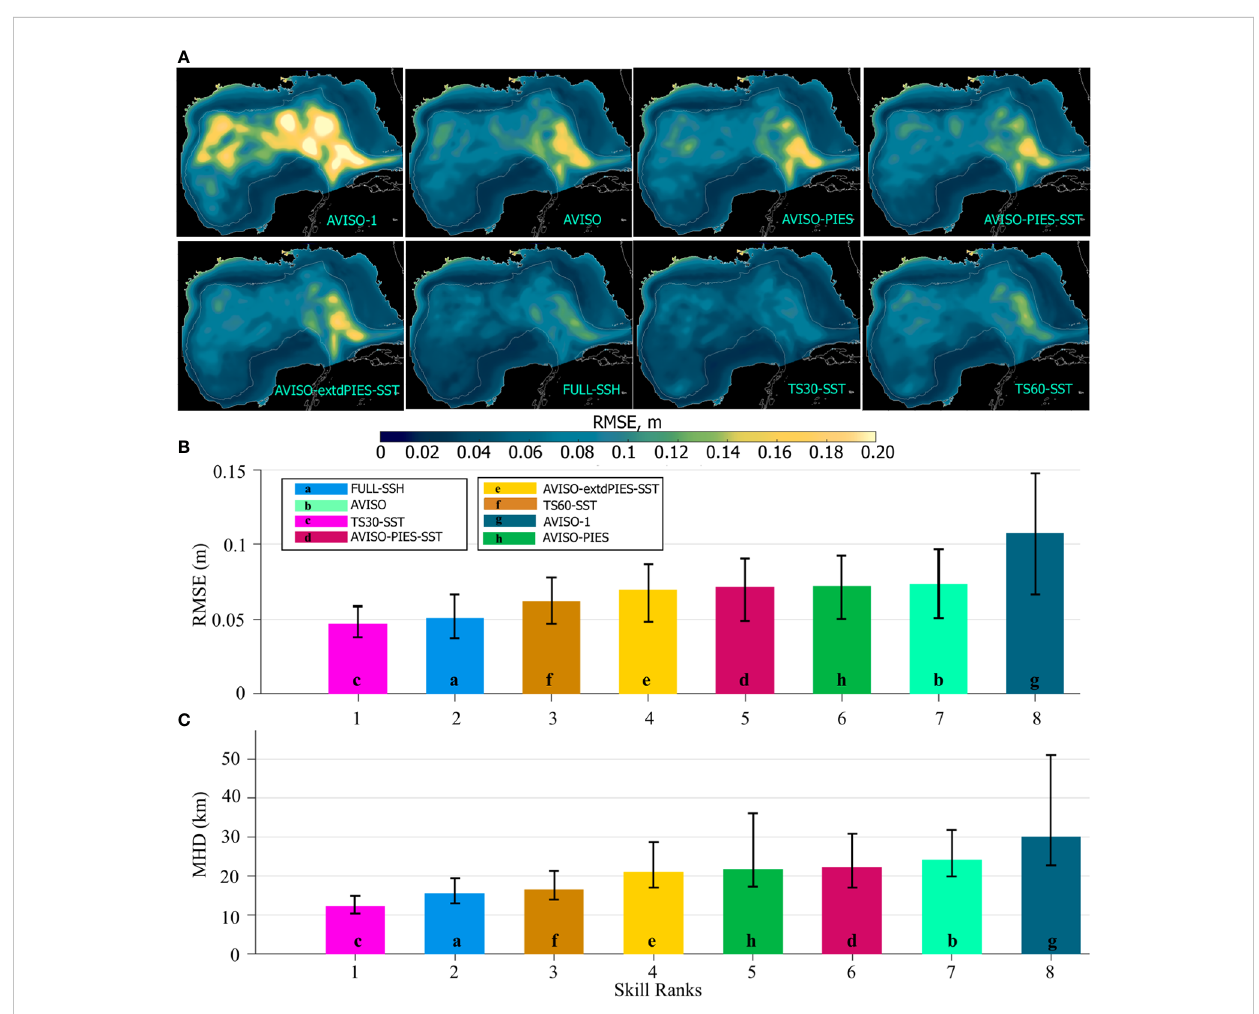
FIGURE 8 (A) Maps of mean RMSE (m) between daily SSH fi elds from the OSSE analysis runs shown in Figure 7 and from the NR (NEMO). The RMSE is averaged over 2011 – 2012. The gray contour is the 200-m isobath. The OSSEs are indicated in the maps. (B) RMSE (m) between SSH from the OSSE analysis runs and the NR over the hindcast period (2011 – 2012). The colored bars show the median RMSE with colors corresponding to the OSSEs. The hindcasts are ranked based on the median RMSE. The vertical black lines indicate the IQR. The letters in the bars are for ease of color identi fi cation. (C) MHD scores computed for the LC/LCE contours derived from the OSSE analysis SSH fi elds versus the NEMO NR. The bars show the median MHD scores by OSSEs. The hindcasts are ranked based on the median MHD